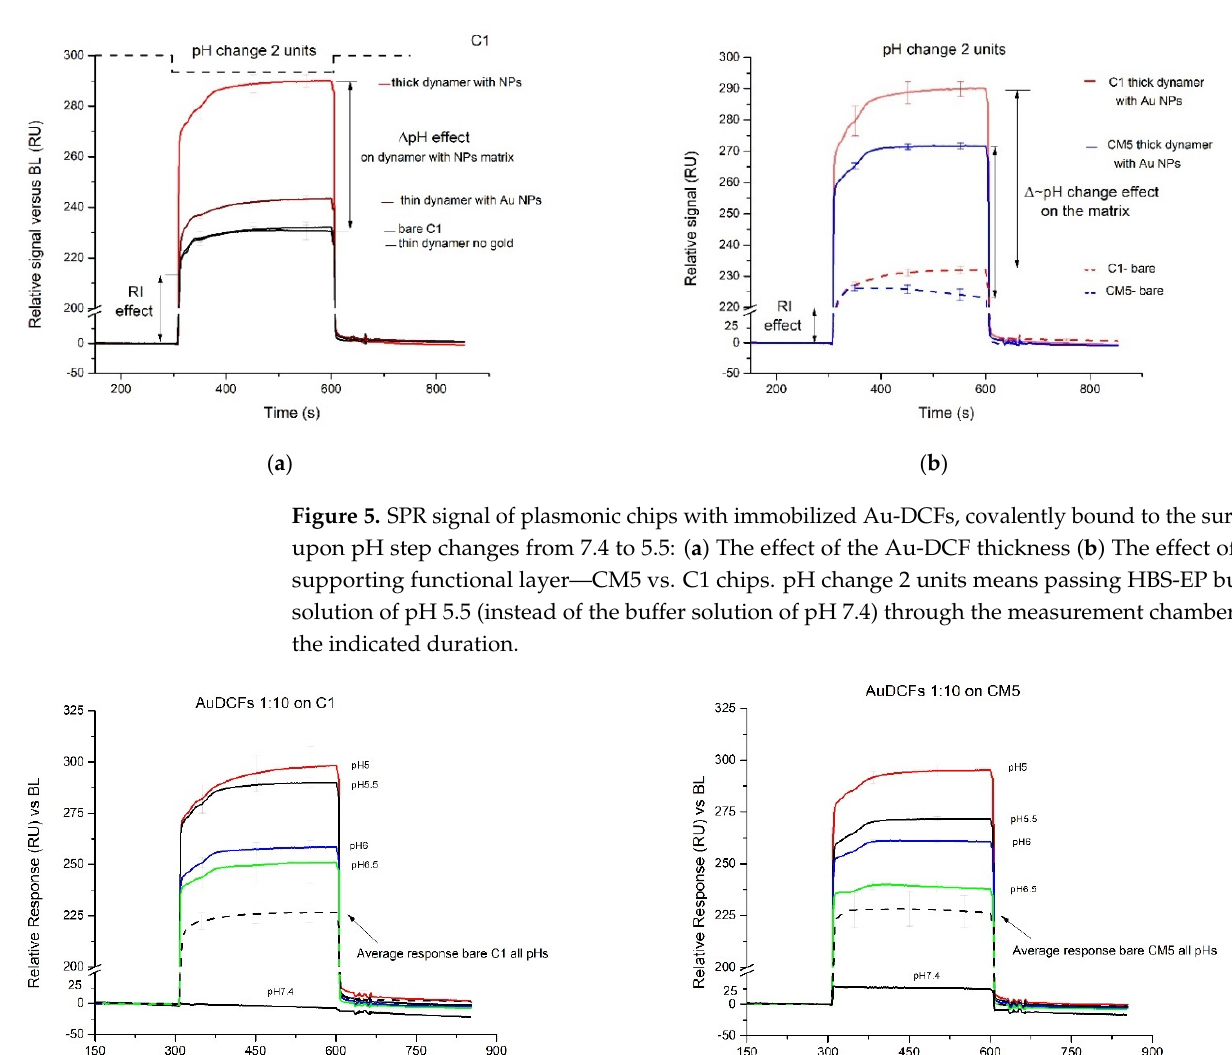
Figure 7. SPR response dependence on pH step changes (towards acidic domain) of the same Au- DCFs covalently immobilized on C1 (red) and CM5 (black) surfaces. Data is referenced versus the blank channel (without the Au-DCF) on each type of chips. 4. Conclusions Dynamic constitutional frameworks augmented with embedded gold nanoparticles (i.e., Au-DCFs) were successfully prepared and investigated using a SPR assay. Au-DCFs were immobilized on two different types of functional chips to assess the influence of the